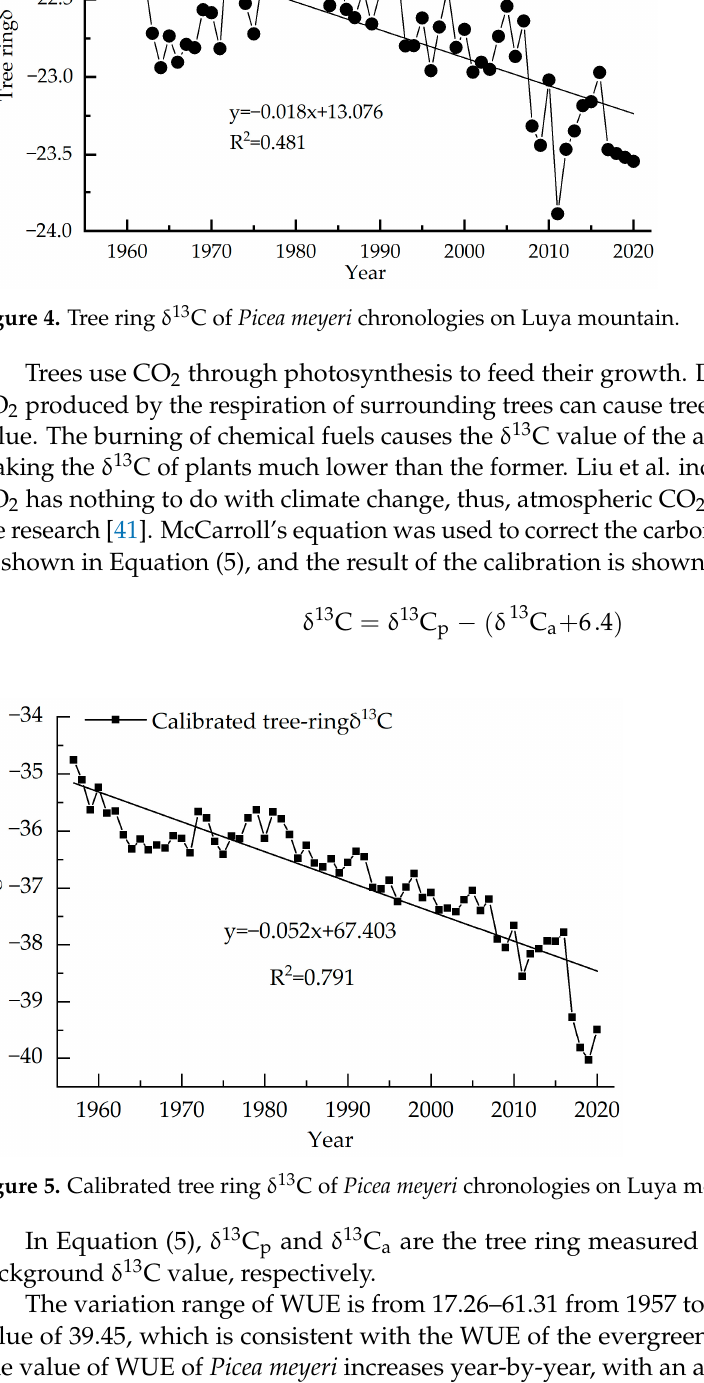
Figure 6. Inter-annual variations of WUE of Picea meyeri on Luya mountain. 3.2. Response of Stable Carbon Isotope Sequence to Changes in Temperature and Precipitation The above analyses show that the variation trends of δ 13 C and WUE of Picea meyeri are the opposite. In order to investigate the possible “lag phenomenon”, correlation anal- ysis should be made between the two sequences and the meteorological factors of the pre- vious year. The Pearson correlation analysis results of the two sequences and climate fac- tors, such as average annual temperature and annual precipitation, are shown in Table 1. The results of the mean temperature (Tmean), maximum temperature (Tmax), minimum temperature (Tmin), mean precipitation (Pmean), relative humidity (RH) and vapor